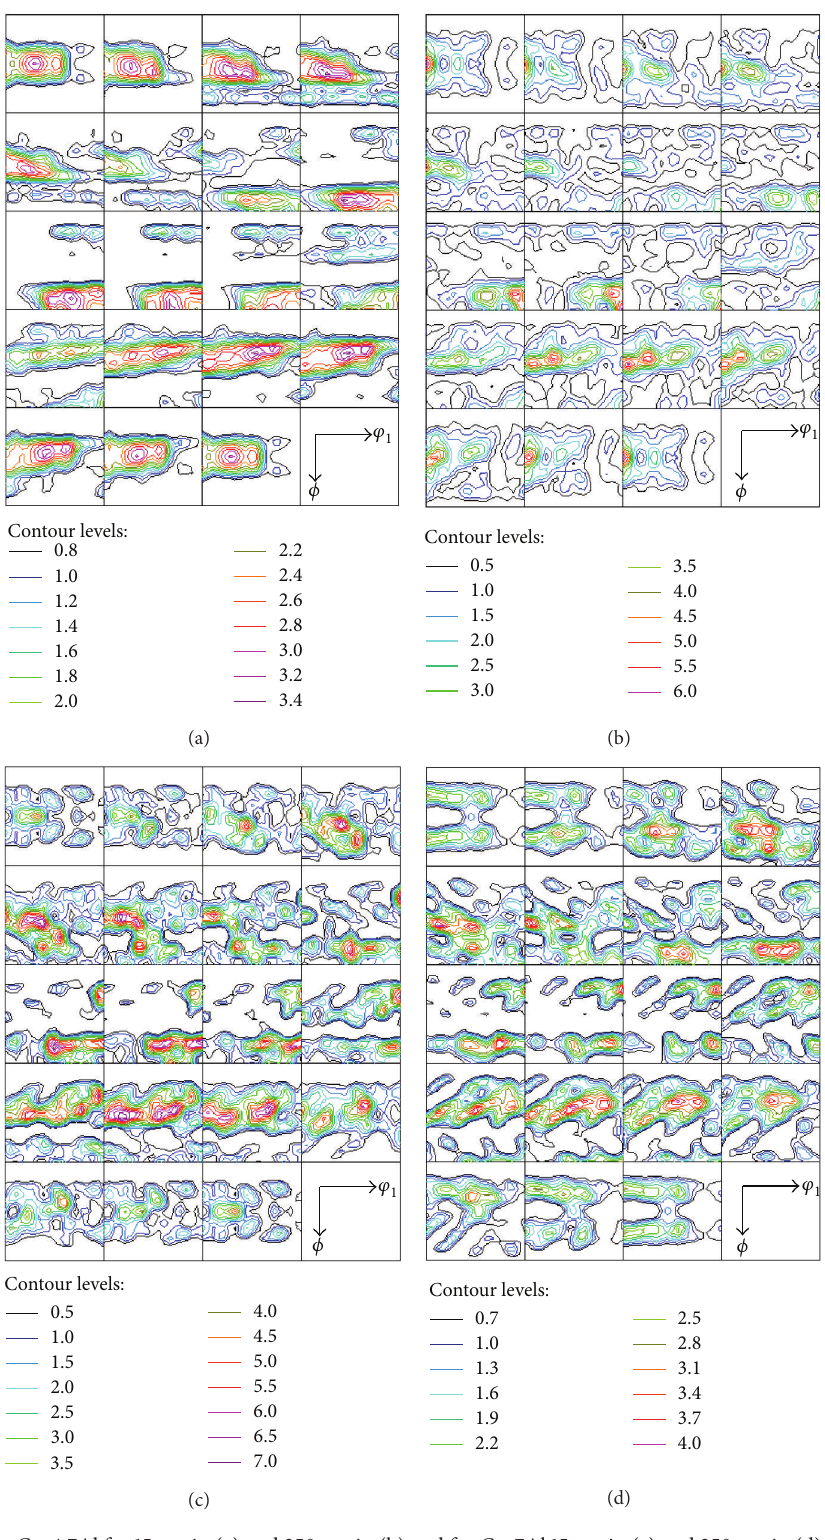
Figure 11: ODF plots for Cu-4.7Al for 15 𝜇 m in (a) and 250 𝜇 m in (b) and for Cu-7Al 15 𝜇 m in (c) and 250 𝜇 m in (d). All samples were plane strain compressed to a true axial strain of